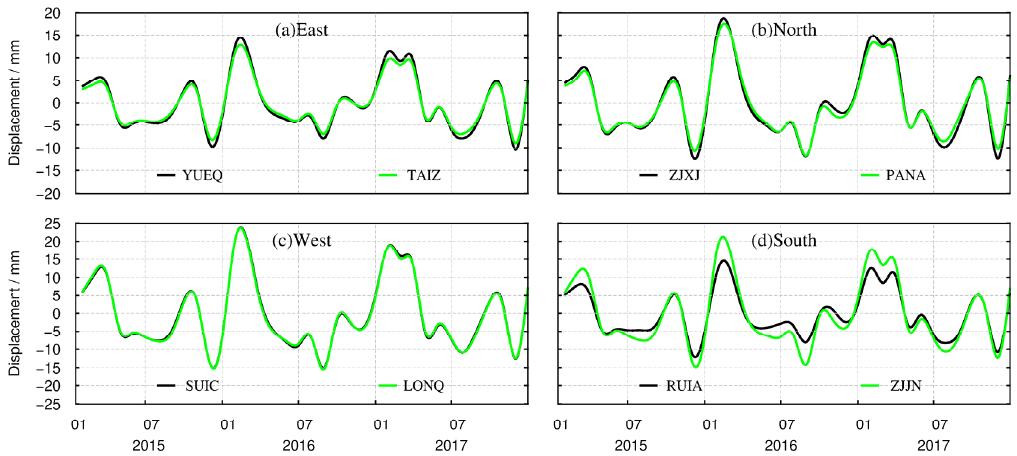
Figure 8. Temporal distribution of vertical deformation derived from the terrestrial water load at CORS positions.